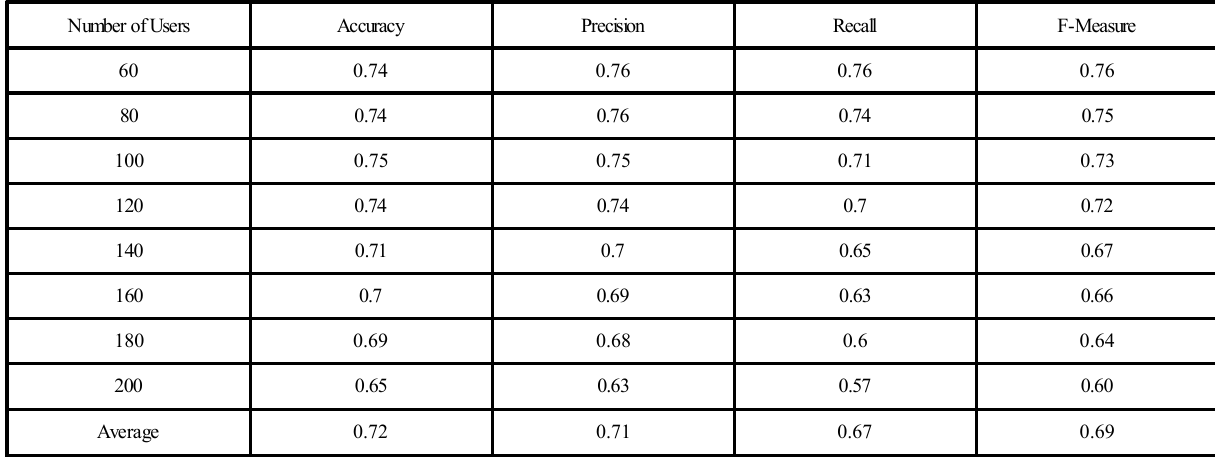
TABLE 1. PROPOSED HYBRID RECOMMENDATION